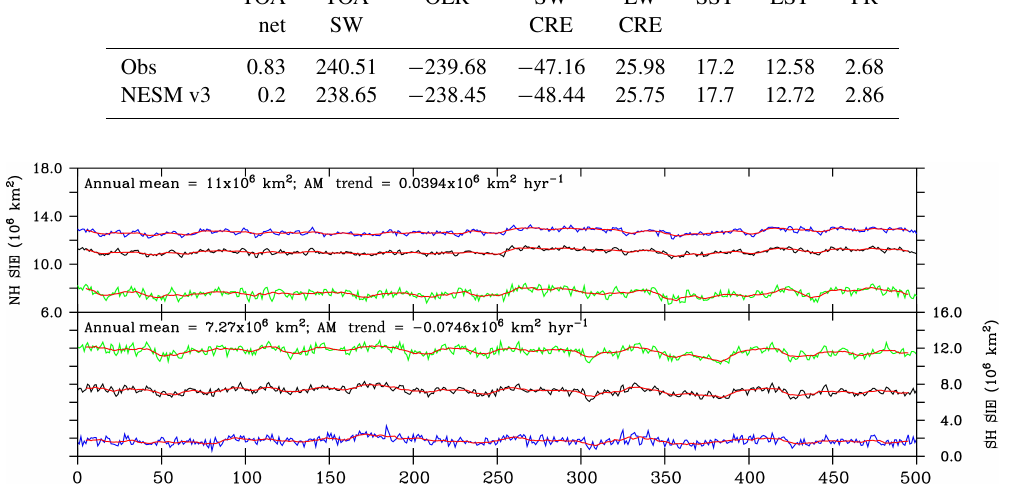
Figure 5. Results from the preindustrial control experiment. The Northern Hemisphere (NH) and Southern Hemisphere (SH) sea ice extent (SIE; unit: 10 6 km 2 ) time series from year 0 to 500 in the preindustrial control experiment. The black, blue, and green lines represent the annual mean, February, and September SIEs, and the red lines are the corresponding 9-year running mean. The long-term trends in annual mean SIEs are indicated in the upper left corner of each